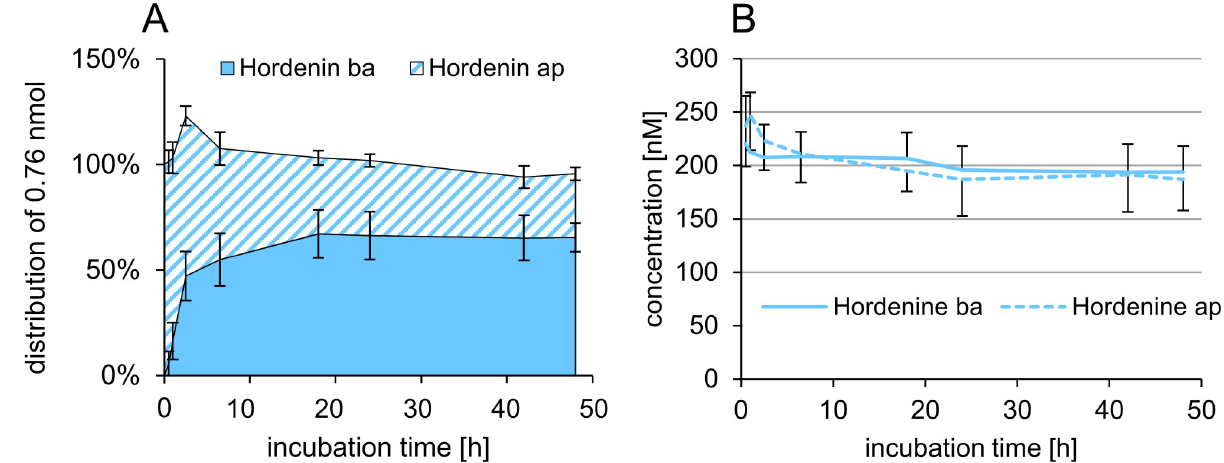
Fig 5. Passive transfer (A) and active transport (B) of hordenine through the PBCEC monolayer. The passive transfer of hordenine from apical (ap) to basolateral (ba) compartment was determined after apical application of 1 μ M hordenine ( n = 3 × 3). Hordenine was quantified using HPLC-MS/MS and normalized to the initial amount (0.76 nmol) on the apical side. The active transport experiments based on the recovery of 200 nM hordenine in the apical and basolateral compartment after incubation of equimolar concentrations in both compartments ( n = 3 × 3). Data are presented as means ± standard